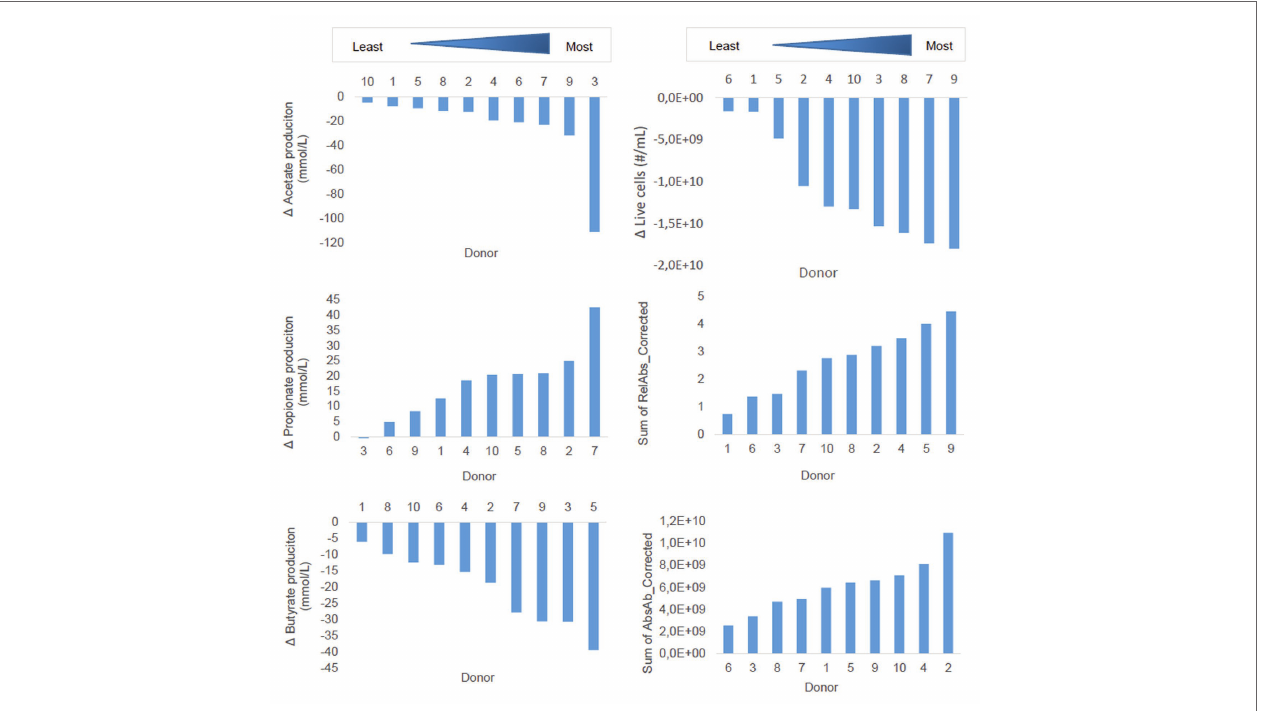
FIGURE 9 | Ranking of donors of fecal material for 48 h batch incubations in sugar depleted medium supplemented with five emulsifiers at four concentrations. Donors were ranked along the principal parameters impacted by the emulsifiers. Measures were calculated based on cumulative (sum of all treatments) change in 48 h production of SCFA or cumulative 48 h change in living cell counts, relative or absolute abundances of Escherichia / Shigella